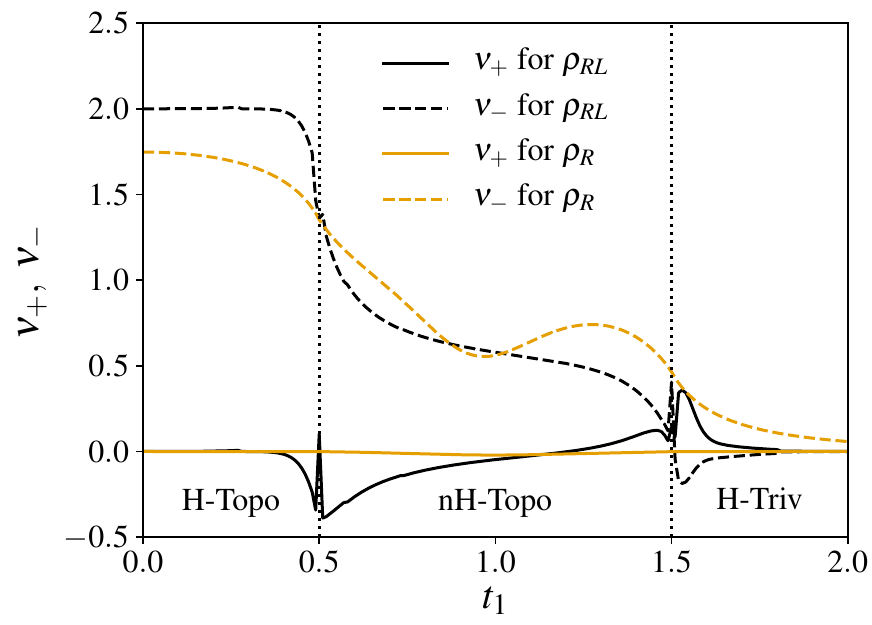
Figure 4: Topological invariants ν + and ν − of the biorthogonal and the right en- tanglement Hamiltonian in the chiral limit γ = 0.5 and µ = 0, as a function of the hopping t . We consider a system of size L = 801 and a subsystem of size l = 40. 1 The vertical dashed lines mark the PBC phase transitions. For the biorthogonal den- sity matrix, in phase “H-Topo” and “H-Triv”, the topological invariant takes the same values as in the original Hamiltonian. On the other hand, in the intermediate phase “nH-Topo”, the real space topological invariant are no longer quantized as the Hamil- tonian becomes long ranged. The phase transitions are nonetheless well marked. For the right density matrices, ν + = 0 while ν − is not quantized, as expected from a Her- mitian Hamiltonian of class AI